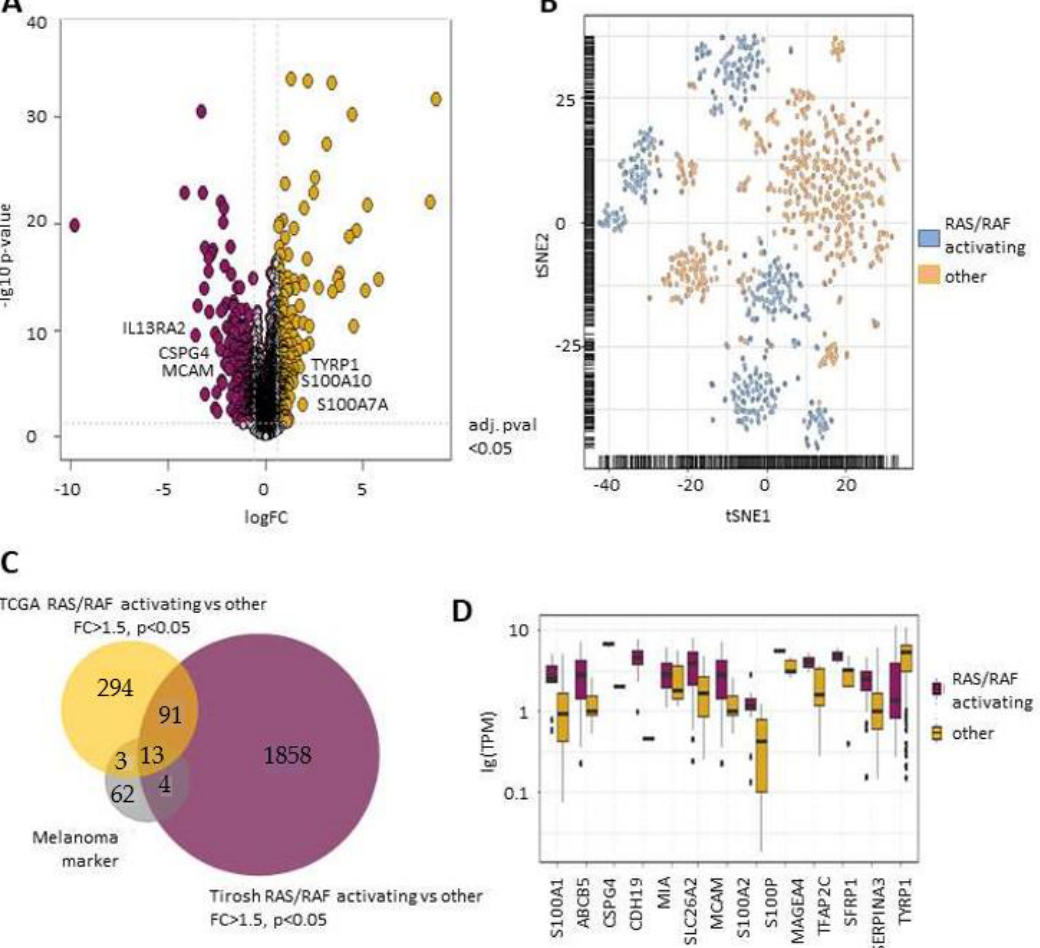
Figure 1. BRAF/NRAS mutations determine cellular marker expression in malignant melanoma. ( A ) Volcano plot of differentially regulated genes in the TCGA data set, comparing melanomas containing BRAF/NRAS mutations (RAS/RAF activating) and not BRAF/NRAS mutated melanomas (other). Significantly reduced genes (< lgFC −1) are depicted in violet; significantly increased genes (> lgFC 1) in yellow ( B ) t -SNE plot, based on melanoma markers expressed on single cells (Tirosh et al.), derived from BRAF/NRAS mutated tumors and not BRAF/NRAS mutated tumors. ( C ) Venn diagram of all differentially expressed genes between RAS/RAF activating and other tumors of the TCGA and Tirosh cohorts and specific melanoma marker genes. ( D ) Significantly differentially expressed melanoma marker genes in the Tirosh data set. *= p < 0.05.